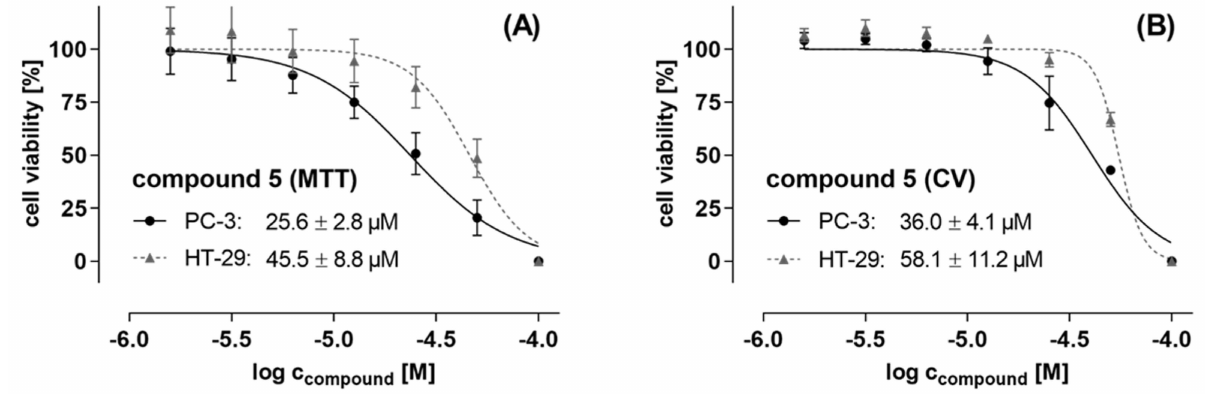
Figure 4. Effect of peperobtusin A ( 5 ) on ( A ) the metabolic cell viability of prostate PC-3 cancer cells and colon HT-29 cancer cells, as determined by MTT assay after 48 hours of cell treatment. ( B ) General cytotoxic and antiproliferative effect of 5 on both cancer cell lines under comparable treatment conditions, as determined by using crystal violet (CV) assay. Data represent biological duplicates, each comprising technical quadruplicates. IC 50 curves were analyzed and drawn using SigmaPlot and GraphPad Prism software, respectively. IC 50 values are given as mean ±